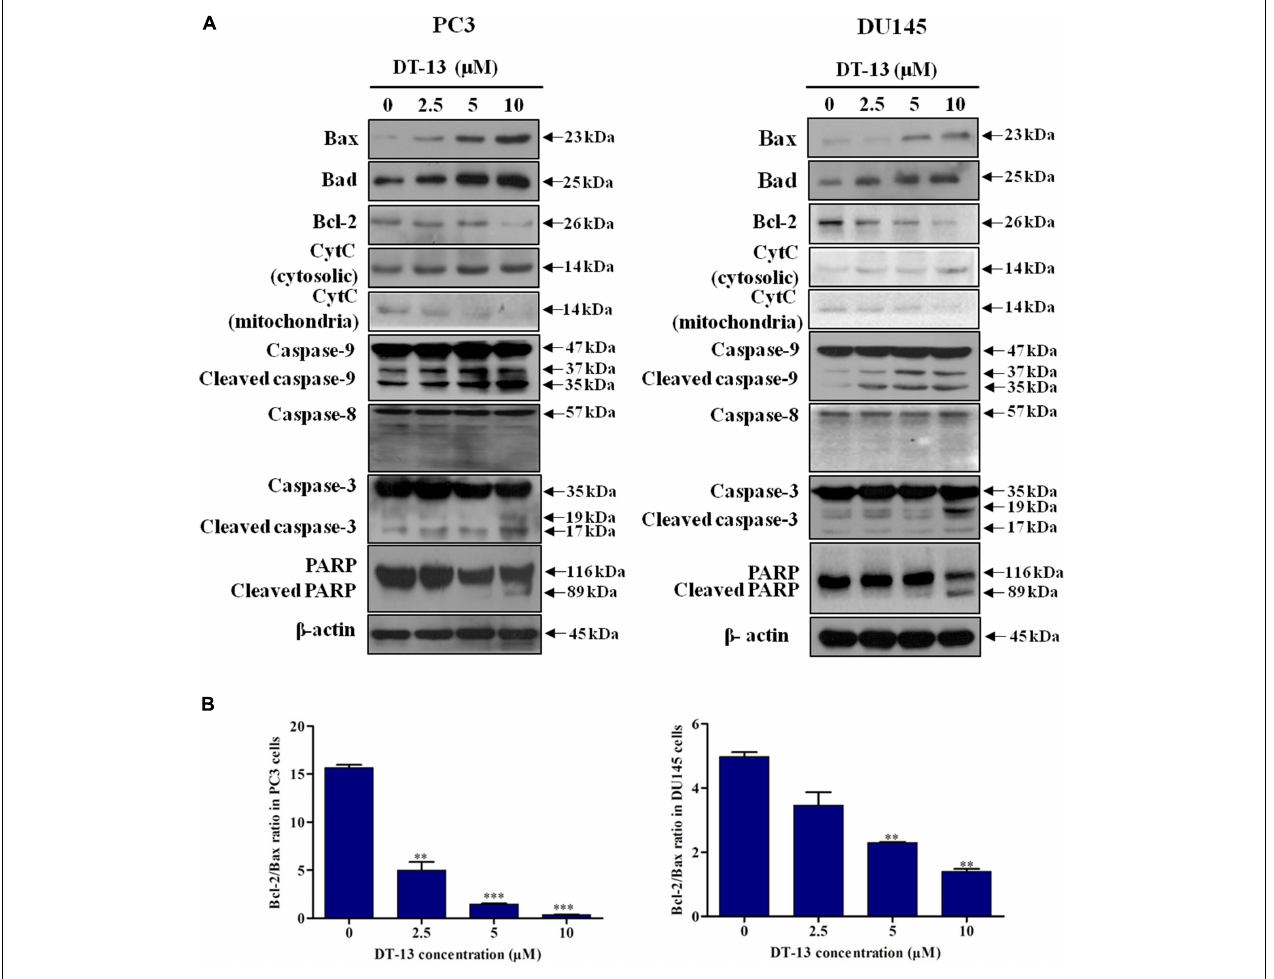
FIGURE 6 | Effect of DT-13 on the expression of apoptosis-related molecules in prostate cancer cells. (A) Western blot analysis of the expression of cell apoptosis-related proteins after DT-13 treatment. PC3 and DU145 cells were treated with 0, 2.5, 5, and 10 µ M of DT-13 for 48 h. The expression levels of Bax, Bad, Bcl-2, cytochrome c (CytC), Casapse-3, -8, -9, PARP, and cleaved Caspase-3, -8, -9, PARP were determined by western blot in both cell lines. (B) Bar graphs show the Bcl-2/Bax ratio in PC3 and DU145 cells. Data are mean ± SD, representative of three independent experiments ( n = 3), ∗∗ P < 0.01, ∗∗∗ P < 0.001, compared with